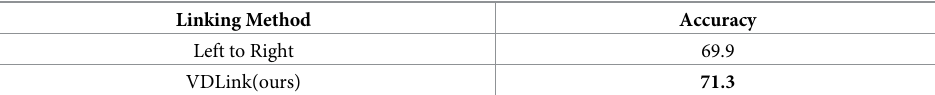
Table 5. Ablation study of